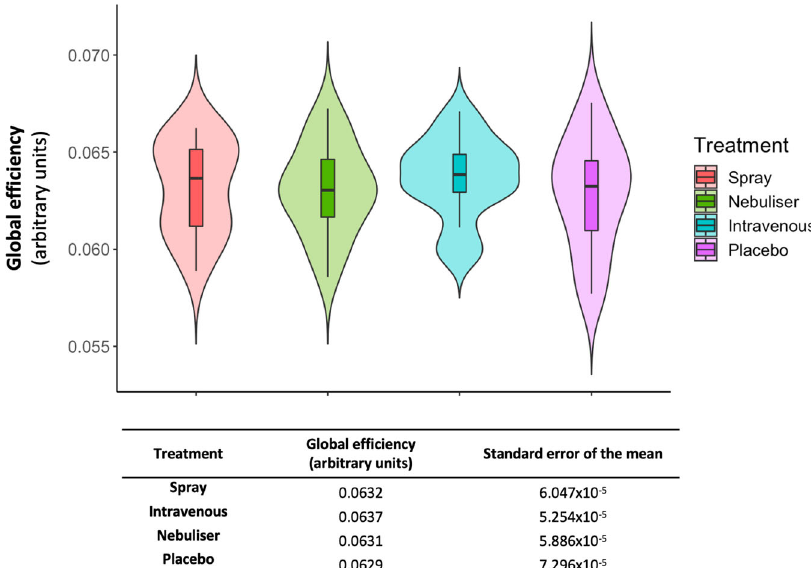
Fig. 1 Effects of exogenous oxytocin on global ef fi ciency. We tested the effects of the four treatment conditions on global ef fi ciency using repeated measures one-way analysis of variance. In the upper panel, we present box and violin plots depicting the distribution of the global ef fi ciency measure for each treatment condition; middle horizontal lines represent the median; boxes indicate the 25th and 75th percentiles. In the lower panel, we present the descriptive statistics for each condition ( n = 16 per treatment